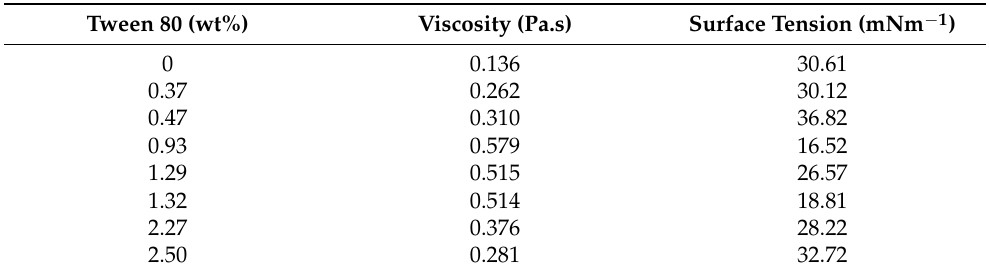
Figure 7. Viscosity (Pa.s) at a shear rate of 10 s − 1 of PEDOT:PSS/Tween 80 (red triangle) and water/Tween 80 (blue square) solutions, with varying Tween 80 concentration (wt%). Table 3. Summary of the viscosity and surface tension obtained for each of the PEDOT:PSS/Tween 80 solutions.